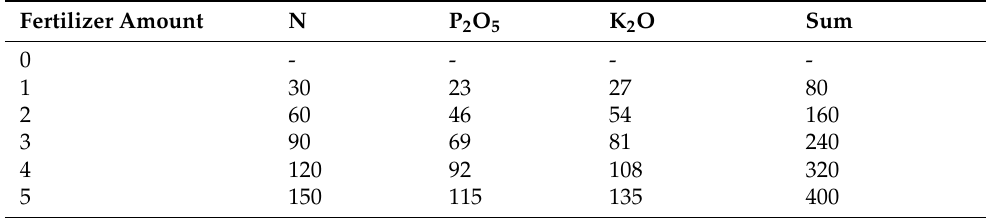
Table 1. Fertilizer input of different treatments in our experiment.